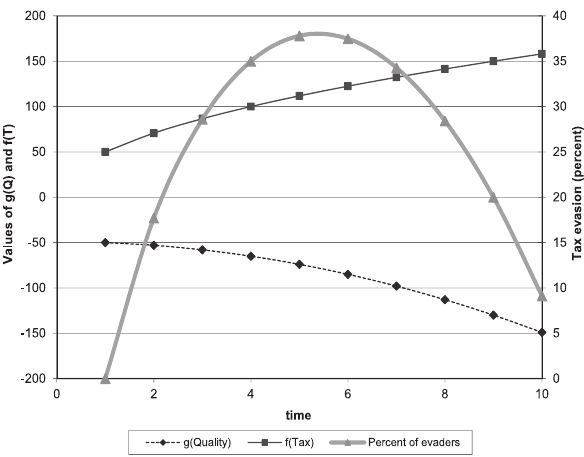
Figure 4 : The Evasional Kuznets Curve as the Sum of the Influence of Perceived Quality of Government Services and Index of